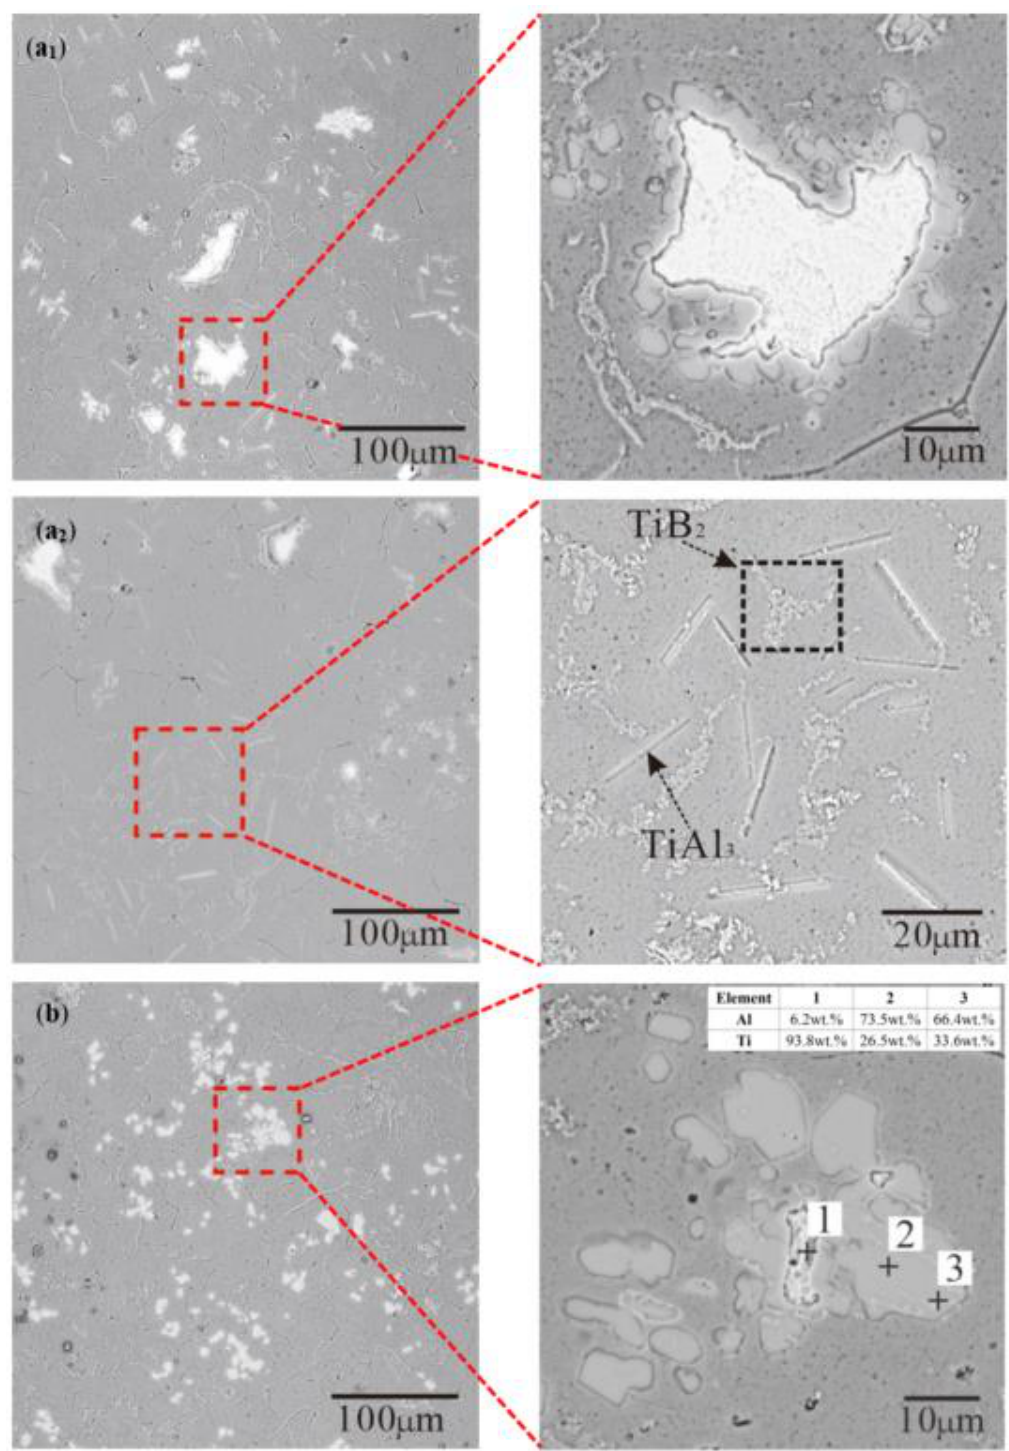
Figure 6. The microstructure and EDS of Al–Ti–B Master Alloy prepared by the Ti-sponge route at 800 °C: ( a 1 ) 15 S reaction time — irregular blocky TiAl 3 ; ( a 2 ) 15 S reaction time — fine, rod-shaped TiAl 3 ; ( b ) 300 S reaction time.